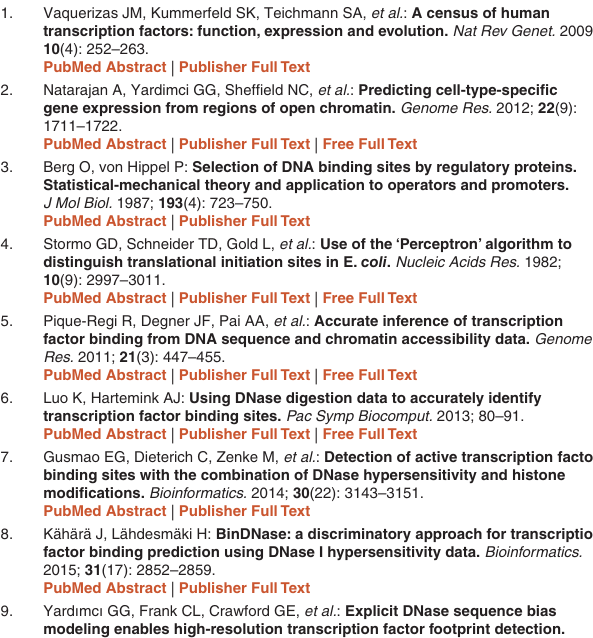
Supplementary Figure 5 (https://doi.org/10.6084/m9.figshare. 9367895.v1) Comparison of misclassification rate depending on the feature design computed on test